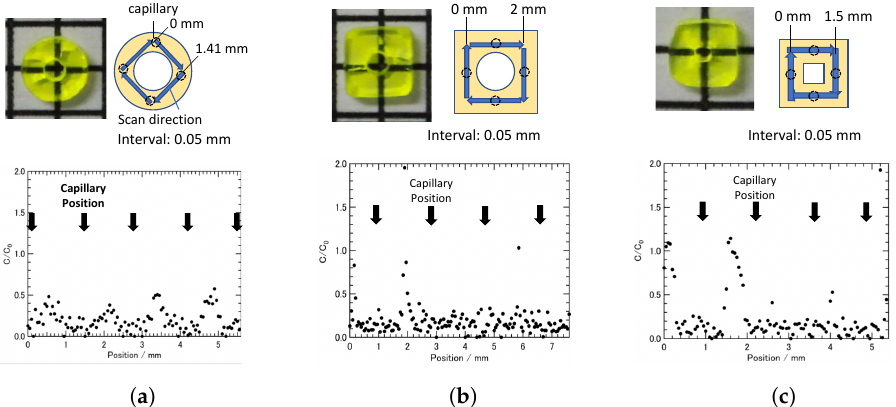
Figure 5. Ce distribution in tangential direction of grown crystals measured by FE-EPMA. ( a ) TYPE1 crucible. ( b ) TYPE2 crucible. ( c ) TYPE3